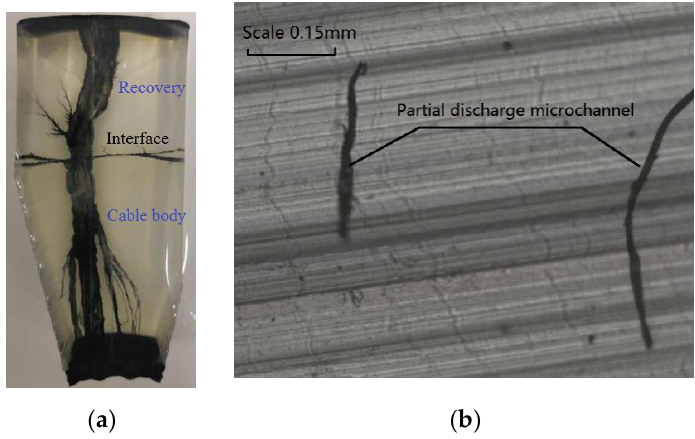
Figure 11. ( a ) Electrical breakdown originating from interface region; ( b ) polarizing fluorescence microscopy images of the carbonized discharging channel in a breakdown EMJ.